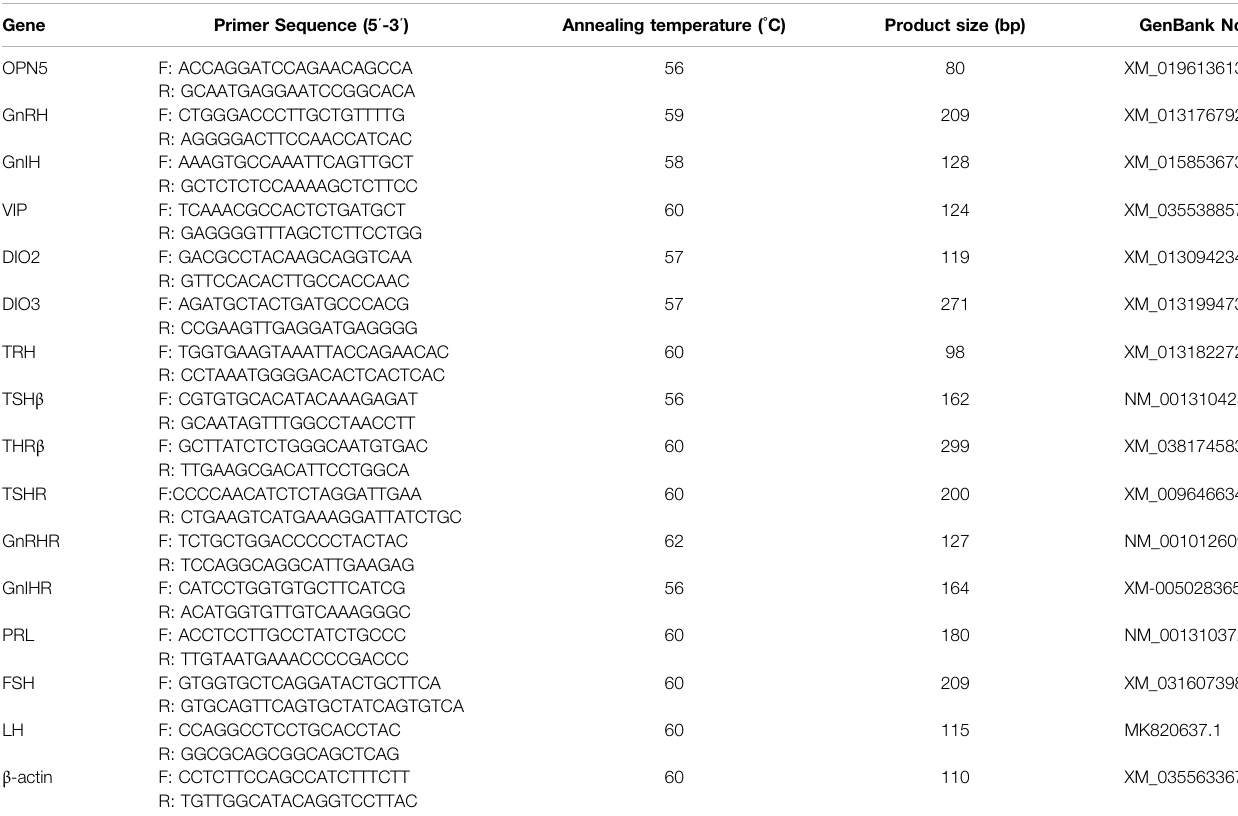
TABLE 1 | Primers for real-time fl uorescent quantitative PCR